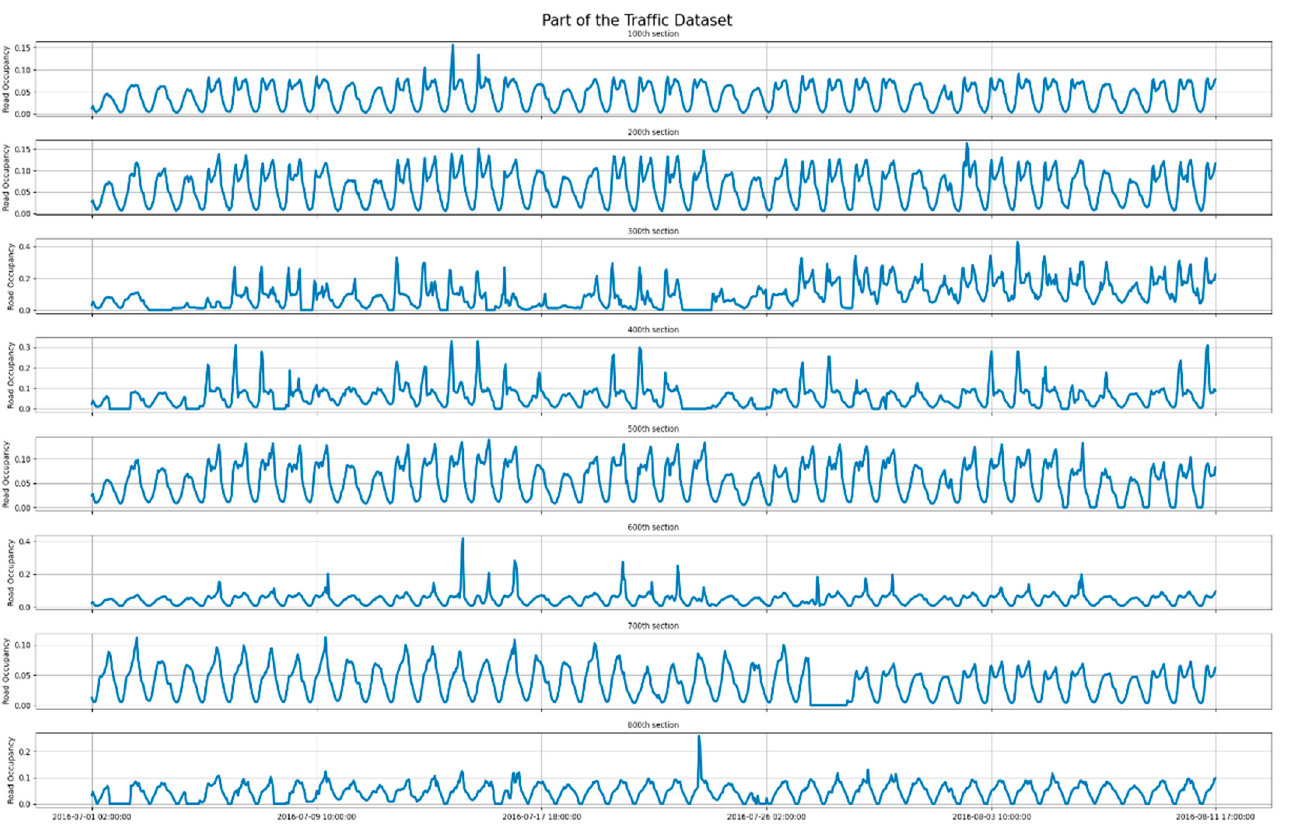
Figure 4. Part of the Traffic dataset used in our experiments.